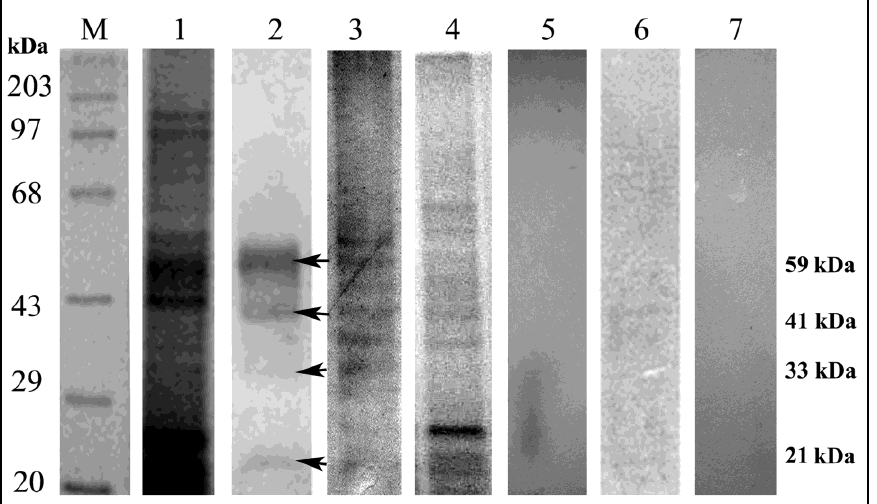
Figure 4. Identification and characterization of RCB midgut binding partners. Lane M: Standard protein molecular weight marker; Lane 1: SDS-PAGE (12%) profile showing Coomassie stained total midgut protein of RCB; Lane 2: Ligand blot analysis of total midgut protein of RCB showing multiple binding partners of CEA; Lane 3: Glycoprotein specific staining of total midgut protein of RCB demonstrating the glycoprotein nature of the binding partners; Lane 4: Total midgut protein profile of RCB (Coomassie stained) after deglycosylation; Lane 5: Ligand blot assay with deglycosylated midgut protein; Lane 6: Ligand blot assay of the total midgut protein using CEA presaturated with α- D -mannose; Lane 7: Negative control: Ligand blot of total midgut protein without CEA probe. (Arrows indicate midgut binding